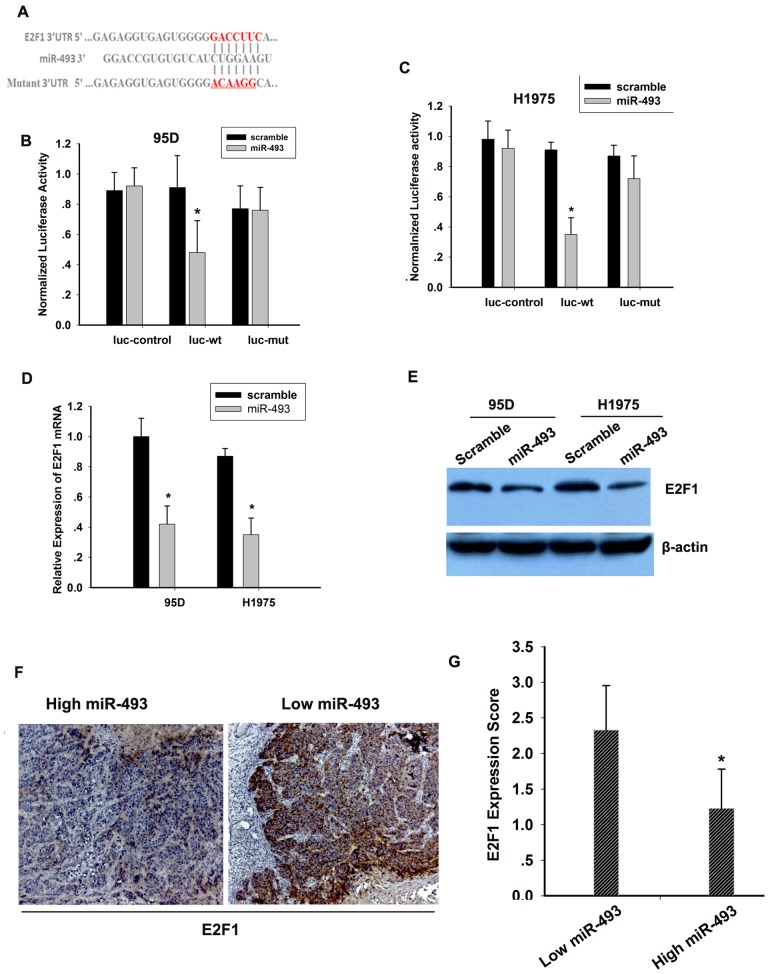
E2F1 is a direct target of miR-493.A, Sequence alignment of microRNAs of the miR-493 and the E2F1 3′-UTR. The E2F1 3′-UTR contains one predicted miR-493-binding site. The seed regions of miR-493 and the seed-recognizing sites in the E2F1 3′-UTR are indicated in red. B and C, Luciferase assay of 95D cells (left-hand side) and H1975 cells (right-hand side), which were co-transfected with miR-493 and a luciferase reporter containing full length E2F1 3′-UTR (Luc-wt) or a mutant (Luc-mut) in which the nucleotides of the miR-493-binding site were mutated. An empty luciferase reporter construct was used as a negative control (Luc-ctrl). The luciferase activities were measured 48 hours post transfection. miR-493 markedly suppressed the luciferase activity in Luc-wt reporter constructs. The data are the means ±s.e.m. for separate transfections (n = 4). *P<0.05 versus scramble. D and E, miR-493 stable transfection reduces the E2F1 protein and mRNA levels. F and G, The level of miR-493 inversely correlated with E2F1 expression. F, The E2F1 expression levels were measured by immunohistochemistry in tumor tissues. These paraffin-embedded tissues specimens were the same source of 65fresh lung cancer tissue aforementioned in figure 1. A representative image of the expression levels of E2F1 in human lung tumor tissues (200×) is shown. G, data are means± s.e.m. * means P<0.05.